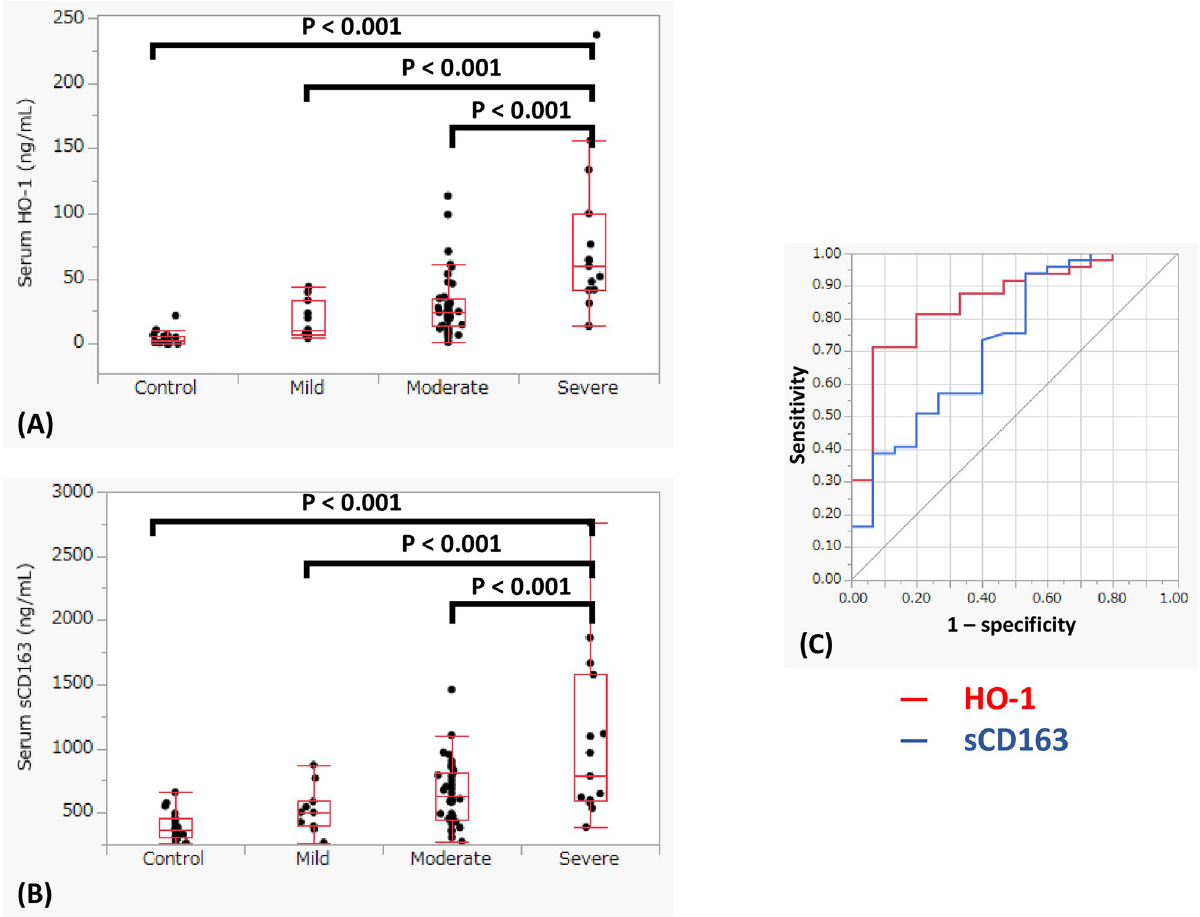
Fig 1. Serum heme oxygenase (HO)-1 and soluble CD163 (sCD163) with COVID-19. (A) HO-1 according to disease severity; (B) sCD163 according to disease severity; (C) Comparison of the prediction of severity between HO-1 (red line) and sCD163 (blue line). (A, B) Both serum HO-1 and sCD163 indicated high levels according to the disease severity of COVID-19. The center bold line is the median value; the bottoms and tops of the boxes represent the 25th and 75th percentiles, respectively; and the whiskers are 95% confidence intervals. (C) Comparing the prediction of disease severity between HO-1 and sCD163 (severe vs. moderate and mild), serum HO-1 shows a higher AUC (0.875) than sCD163 (0.733).